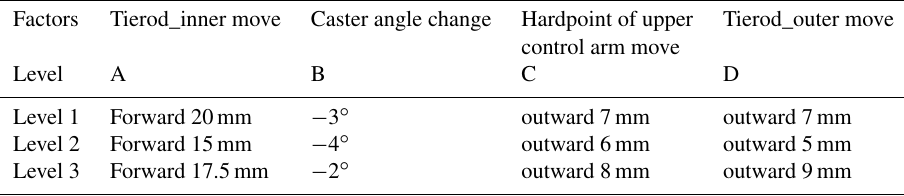
Table 9. The first parameter combination of the control factor level. Factors